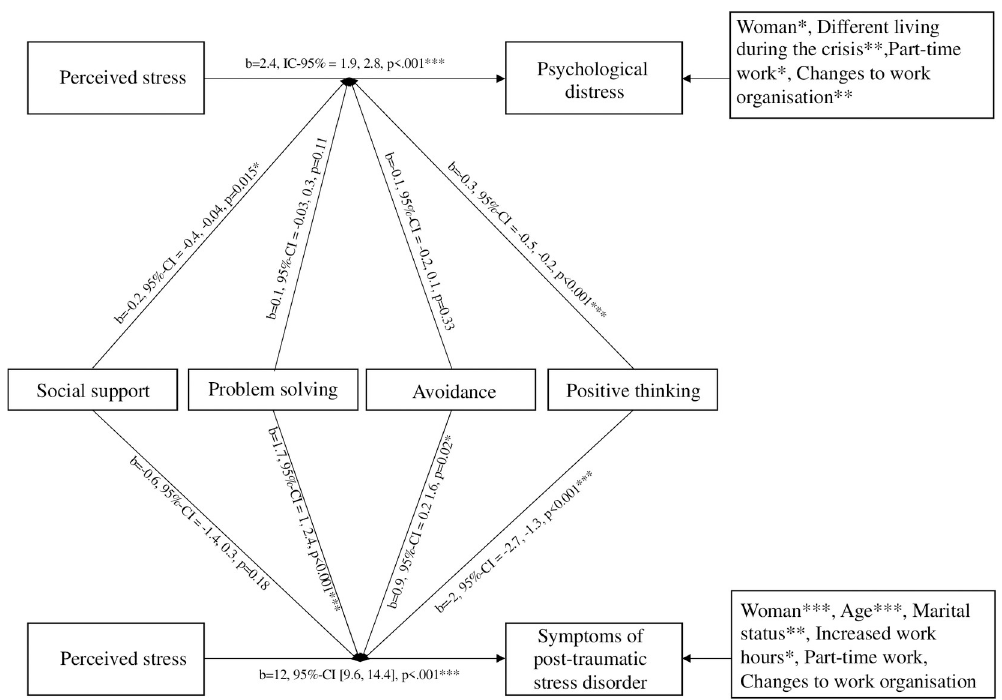
Fig 5. Schematic representation of the moderating effect of coping stress on the relation between stress and mental health.